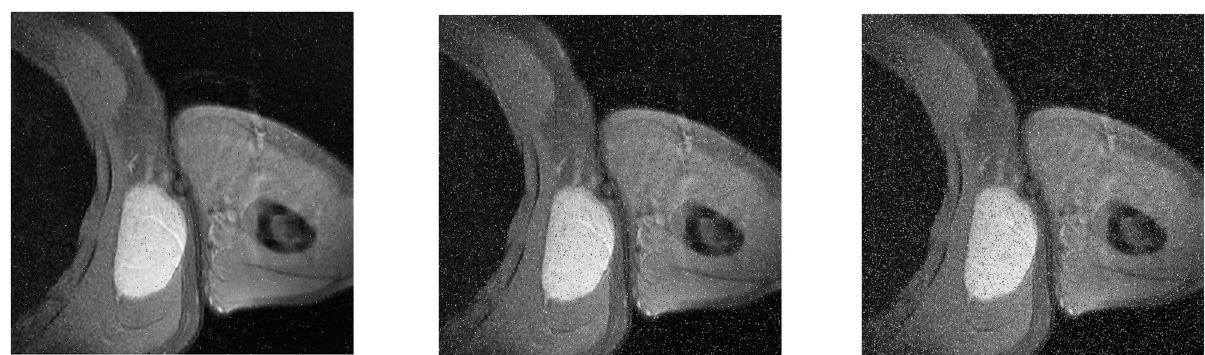
Fig 13. Decrypted images of different levels of salt and pepper noise attacks. (a) 0.005 salt and pepper noise, (b) 0.05 salt and pepper noise, (c) 0.1 salt and pepper noise.